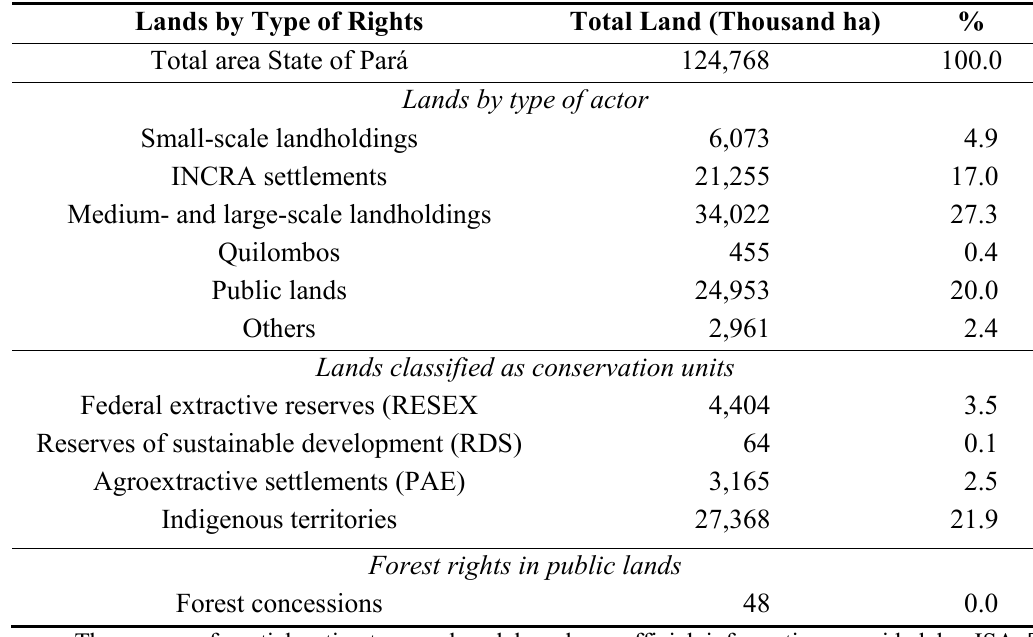
Table 3. Land tenure and forest rights in the State of